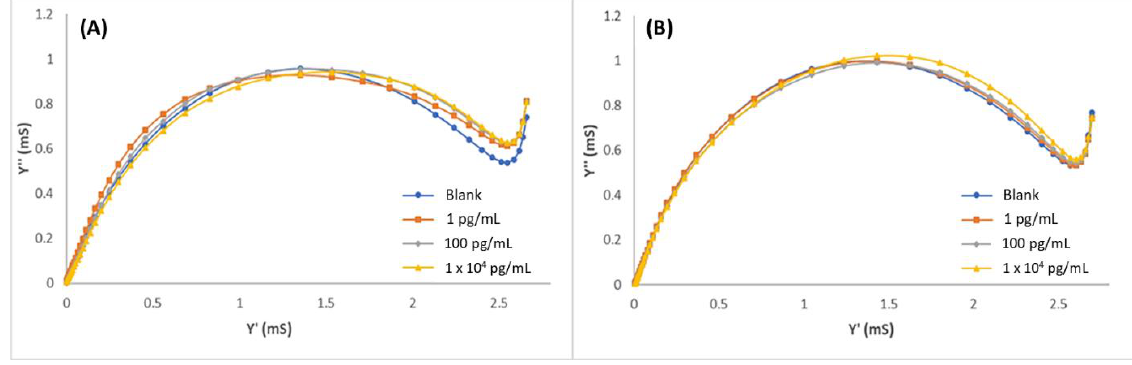
Figure 5. Admittance spectra of MIPPy/GO@Fe 3 O after incubation with ( A ) peroxidase and ( B ) BSA in 1 1 × 10 4 pg/mL range.